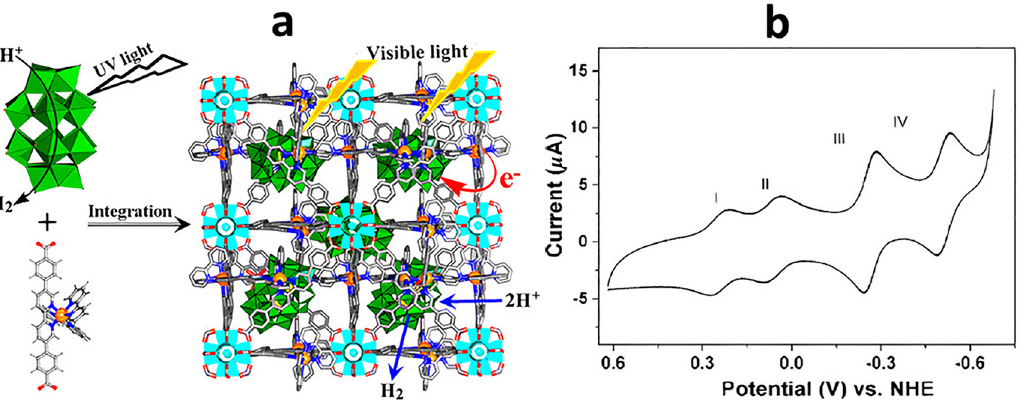
Figure 3: (a) Schematic description of POM@UiO system, showing [P 2 W 18 O 62 ] 6 − , green polyhedra; Zr, cyan; N, blue; Ru, gold; O, red; C, gray. Illustration of visible-light driven excitation of UiO framework followed by electron transfer to the encapsulated POMs for synergistically enhanced H 2 evolution. (b) Cyclic voltammogram of [P 2 W 18 O 62 ] 6 − (2 × 10 − 4 M), showing four oxidation peaks in acidic aqueous electrolyte i.e., 0.2 M H 2 SO 4 + Na 2 SO 4 (pH 1.8) at the scan rate of 100 mV s − 1 . Adopted with permission from ref.